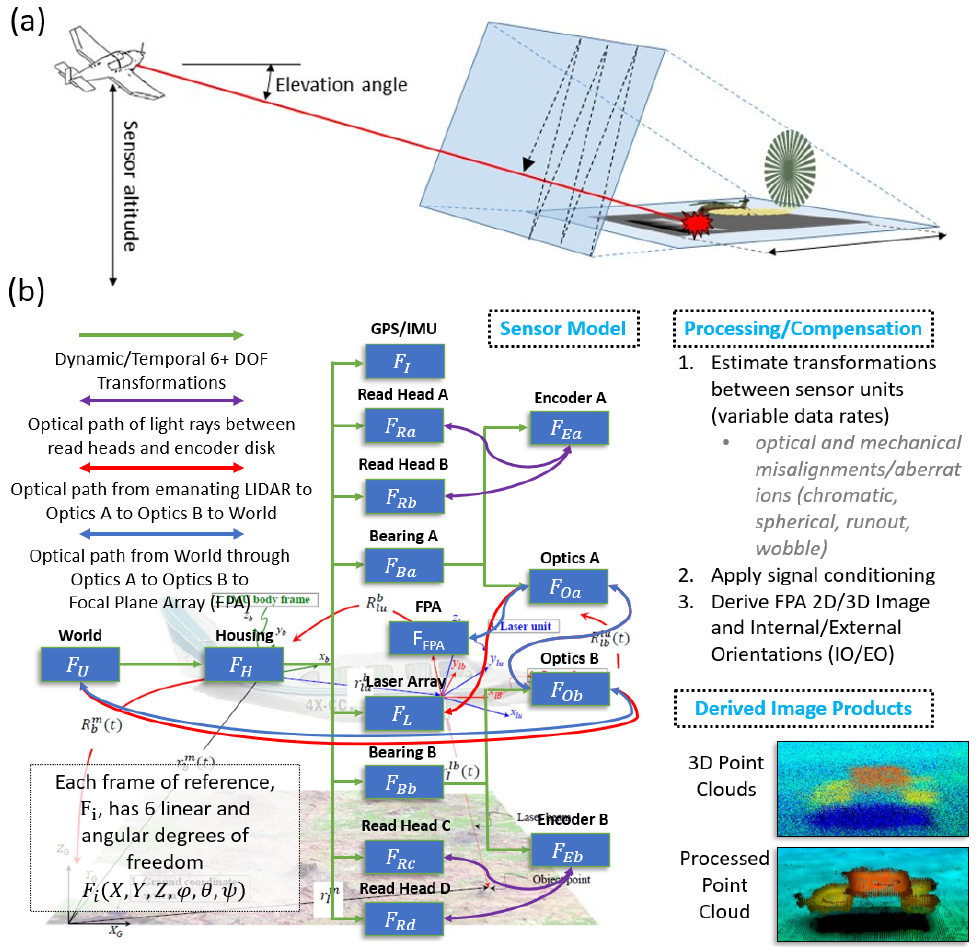
Figure 1. The Kinematically Linked Model Framework (KLMF) [4] incorporates an incredibly complex model of all of the components of a LIDAR system to investigate all the ways that the position and timing of each contribute to the final resolution of derived point clouds. Each component of the sensor has its own frame of reference to enable detailed tracking of its position and